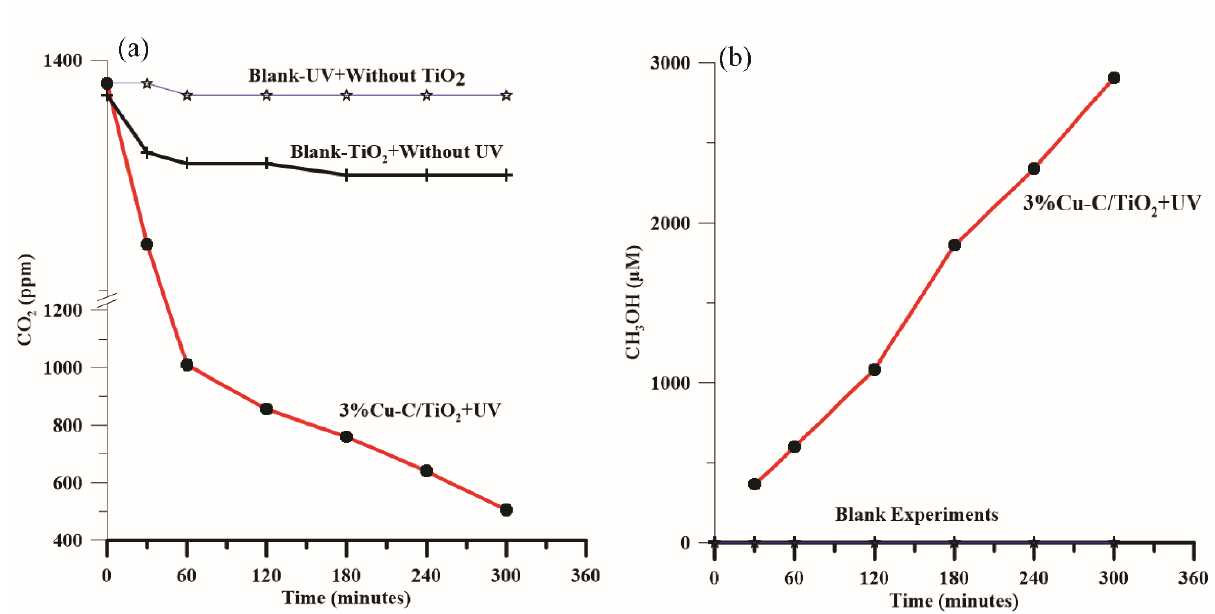
Figure 6: Blank experiment (a); reduction of CO 2 at various conditions, (b); production of methanol at various conditions